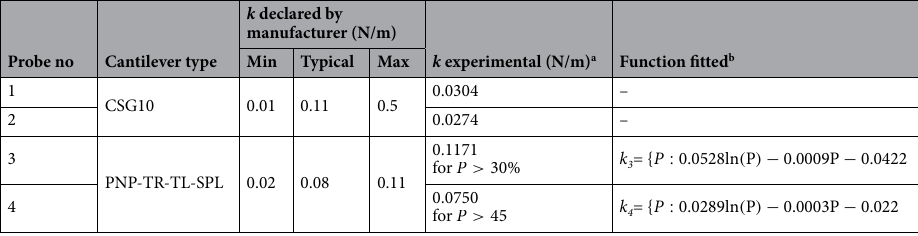
Table 1. Juxtaposition of parameters provided by the manufacturer with the results obtained in the experiment. a The average values are derived from the measuring points of the linear cantilever operation region (Fig. 5). b In the case of cantilevers 3 and 4, the logarithmic function describing characteristics of the cantilever is fitted to experimental points (Fig.